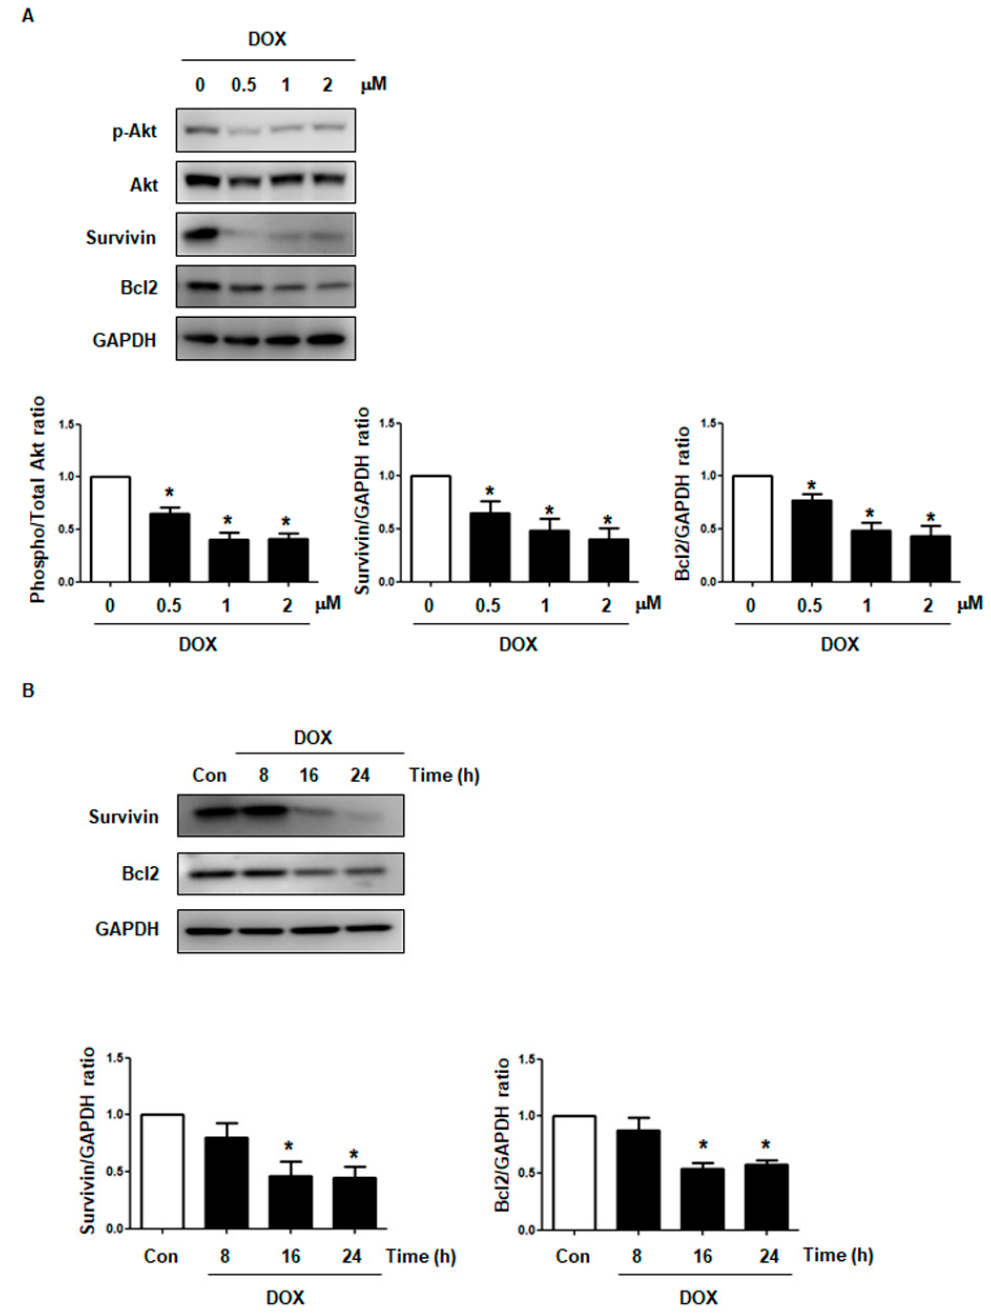
Figure A2. DOX treatment induces cellular apoptosis in a dose/time − dependent manner by downregulating p − Akt, survivin, and Bcl − 2 in cardiomyocytes. ( A ) H9c2 cells were treated with DOX for 24 h. The protein levels of p − Akt, Akt, survivin, Bcl − 2, and GAPDH were measured by Western blotting ( n = 5). * Significant difference compared to the control ( p < 0.05). ( B ) H9c2 cells were with DOX (1 μ M) for the indicated time periods. The protein levels of survivin, Bcl − 2, and GAPDH were measured by Western blotting ( n = 5). * Significant difference compared to the control ( p < 0.05).